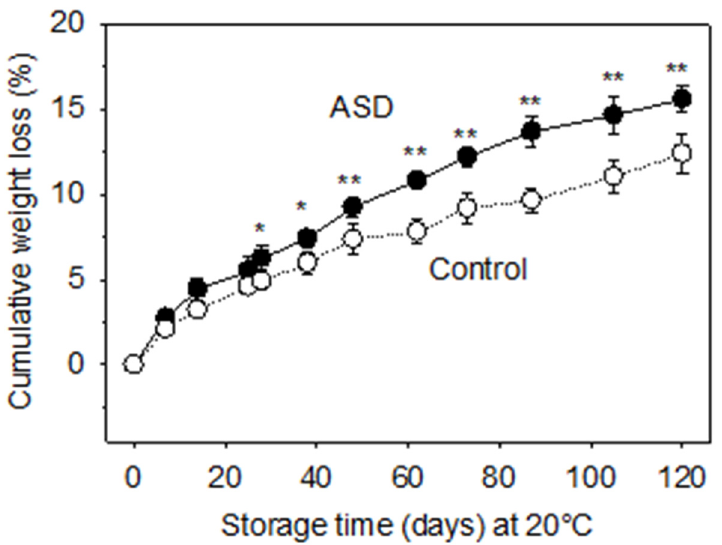
Figure 2. Comparison of weight loss of fruit grown in ASD (black dots) and non-treated soils (white dots). Fruit was stored at 20 °C for up to 120 d. * or ** indicate significant difference at 0.05 or 0.01, respectively, between ASD and control at each storage time.